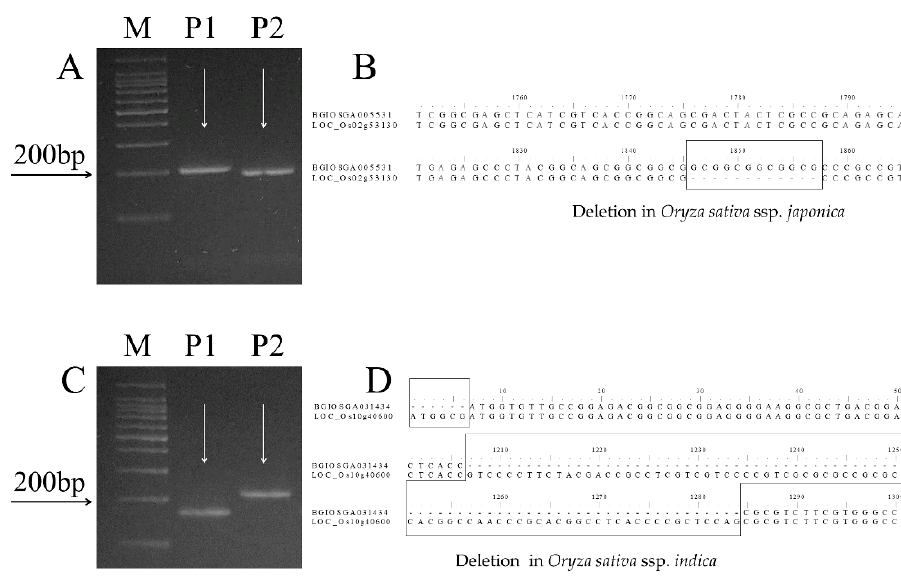
Figure 6. Genotyping of rice cultivars 93-11 (P1, indica ) and Milyang352 (P2, japonica ) using nitrate reductase (NR) and nitrate transporter (NRT) insertion/deletion (InDel) markers. ( A ) OsNR-IND2194 amplified a band size of 200 bp in 93-11 ( indica ) and 188 bp in Milyang352 ( japonica) , ( B ) NR-coding sequence alignment showing deletion of 12 nucleotides (coding for alanine, 4 residues) in Oryza sativa ssp . japonica , ( C ) OsNR-M10-22 amplified a band of 165 bp in 93-11 and 213 bp in Milyang352, and ( D ) NRT-coding sequence alignment showing big deletion in Oryza sativa ssp . indica . M: ladder, 100 bp. Bands were separated using 3% agarose gel electrophoresis. Coding sequences of genes were downloaded from Nipponbare genome database (http://rice.plantbiology.msu.edu) for japonica , and indica rice genome database (http://plants.ensembl.org/Oryza_indica), using ClustalW Multiple Alignment in BioEdit Sequence Alignment Editor.